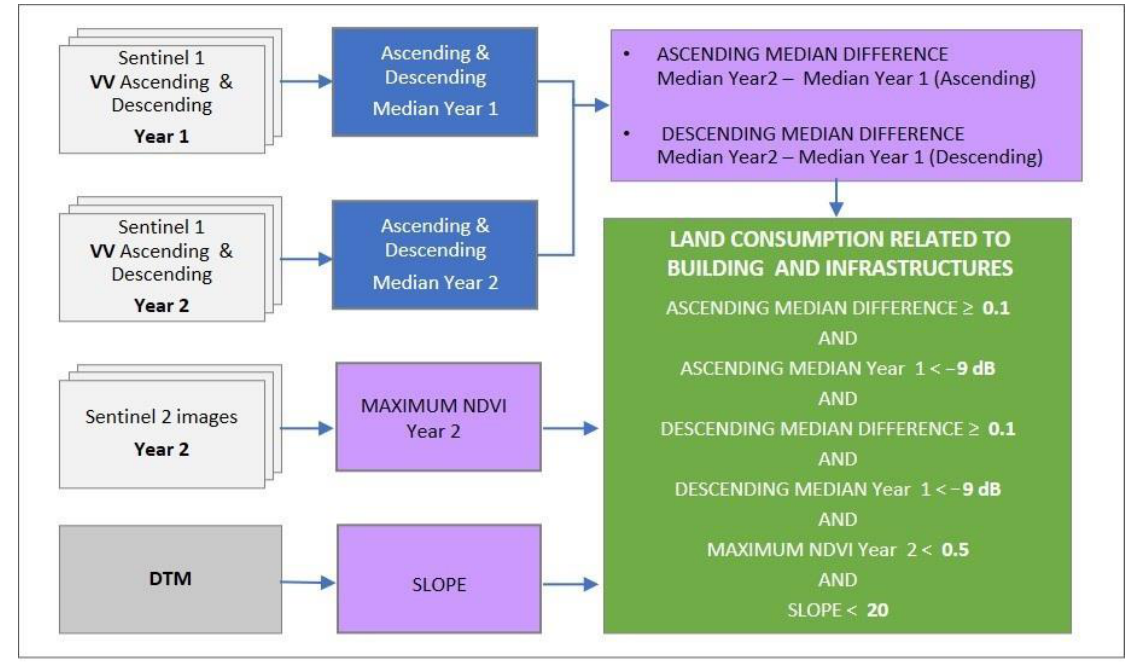
Figure 6. Workflow of the methodology of land consumption related to buildings and infrastructures. The threshold values 0.1 and − 9 dB were evaluated as optimal values to distinguish real changes after several trial and errors. The concurrent conditions for ascending and descending orbits aim at excluding a partial increase in backscatter values related to variations in vegetation and the particular geometry of objects on the ground. The condition ASCENDING (DESCENDING) MEDIAN DIFFERENCE ≥ 0.1 allows us to identify pixels where the construction of a new building caused significant variations in backscatter, while the condition ASCENDING (DESCENDING) MEDIAN Year 1 < − 9 dB excludes areas that were already built during the first year (therefore, having high backscatter values), such as buildings under construction or